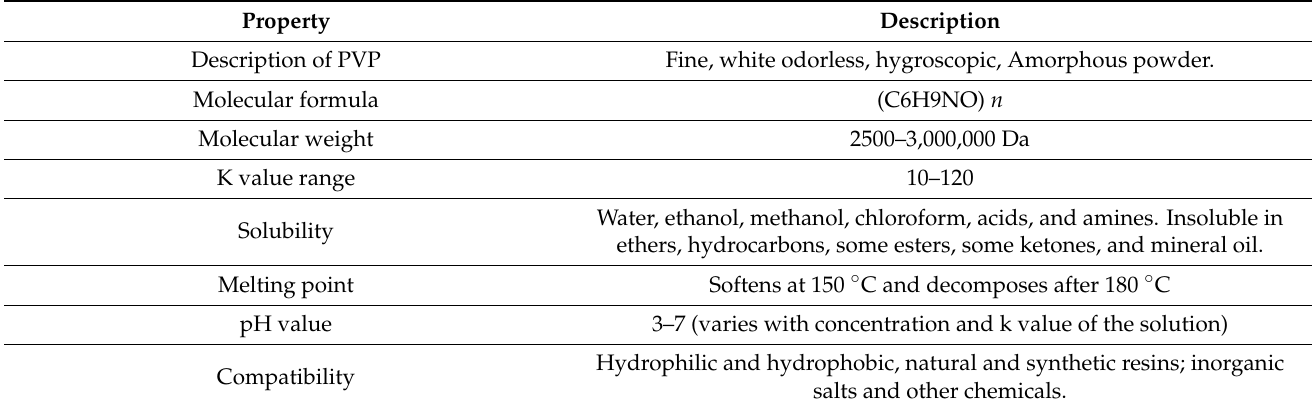
Figure 1. Molecular structure of PVP. Table 1. Physicochemical properties of PVP [9,12–14].